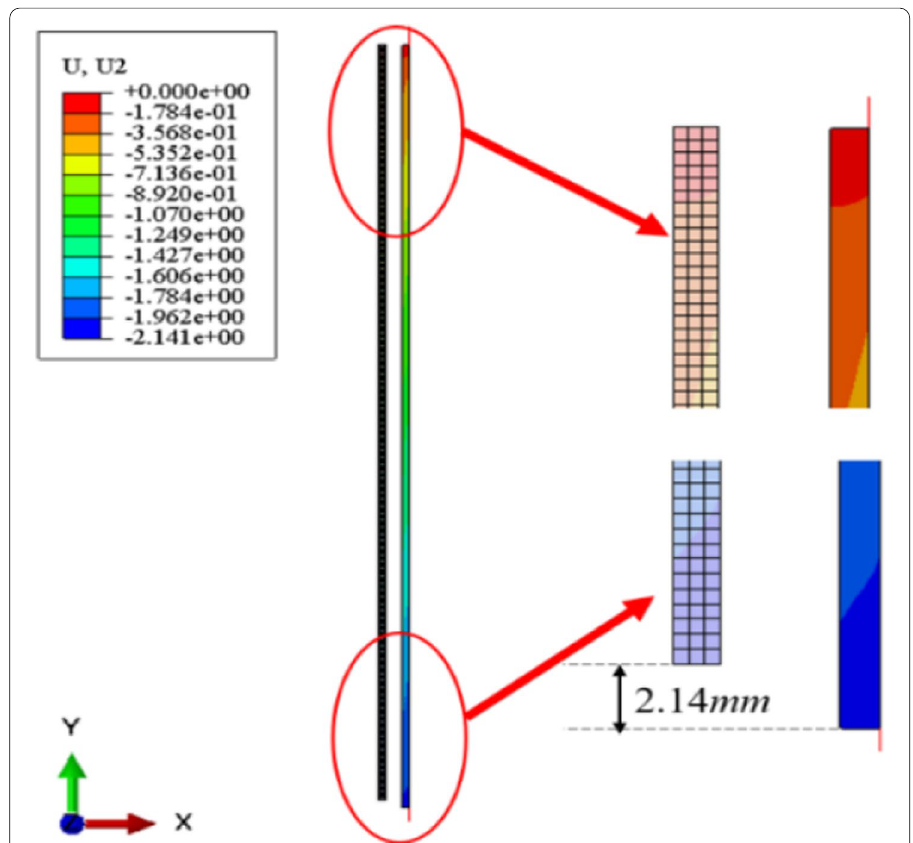
Fig. 5 Axial elongation displacement diagram of rubber cylinder under pressure ( t